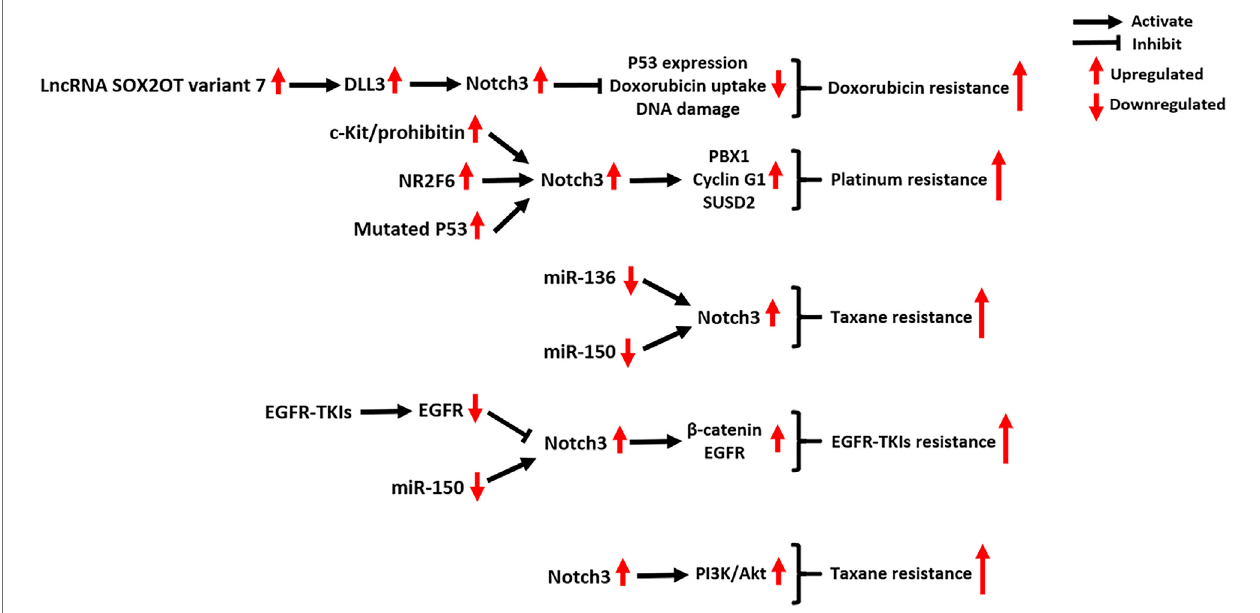
FIGURE 5 | Notch3-related molecular mechanisms in cancer drug resistance. NR2F6: Nuclear Receptor Subfamily 2 Group F Member 6; PBX1: PBX Homeobox 1;SUSD2:SushiDomainContainingtwo;EGFR-TKIs:epidermalgrowthfactorreceptor – tyrosinekinaseinhibitors;PI3K:phosphatidylinositol3-kinase;Akt:AKTSerine/ Threonine